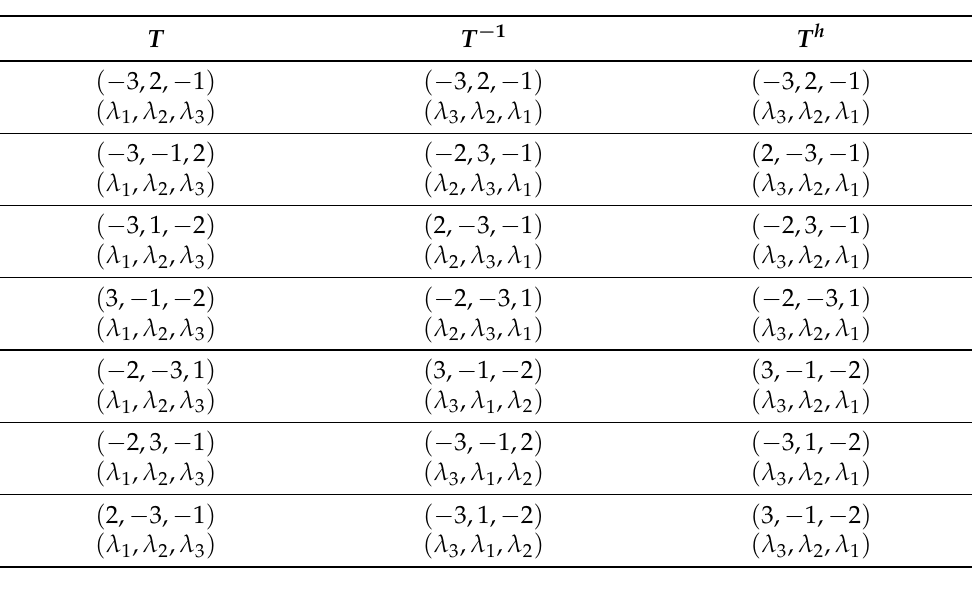
Table 4. 3-IETs with two flips.